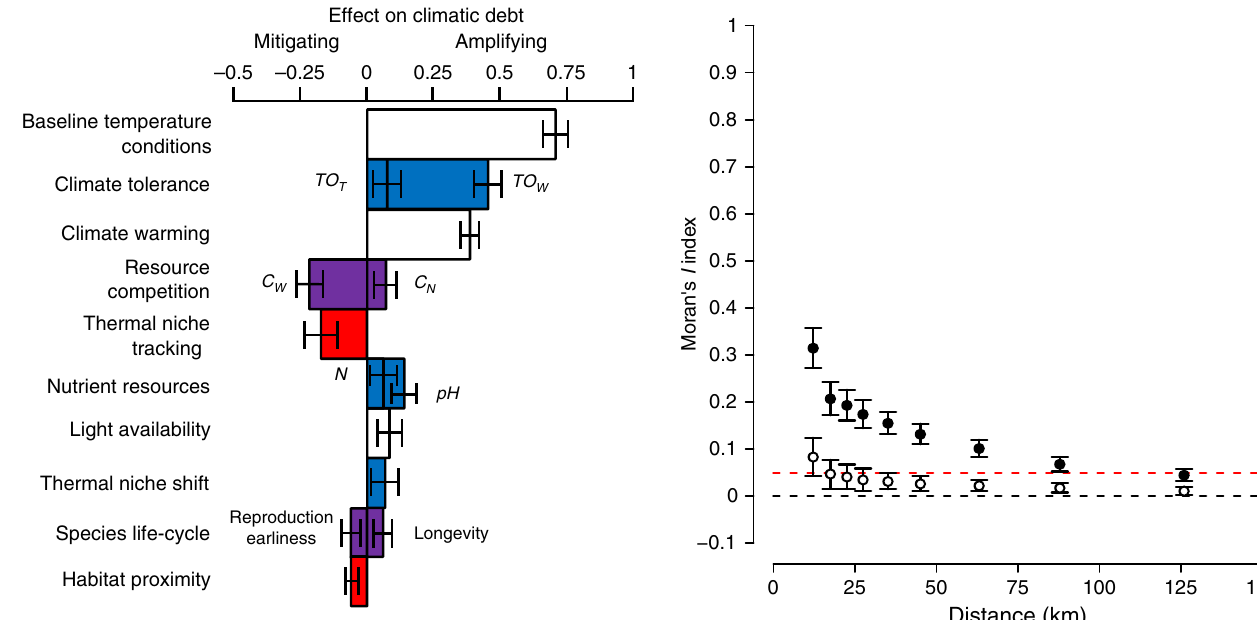
Figure 3 | Spatial correlograms computed from the climatic debt and residuals of the PLS0 model. Black and white dots show mean values of the Moran’s I index computed on the climatic debt and the model residuals ( n ¼ 5,000 bootstraps), respectively. Error bars show 95% confidence intervals. The red dotted line depicts the threshold of spatial autocorrelation significance (that is, I ¼